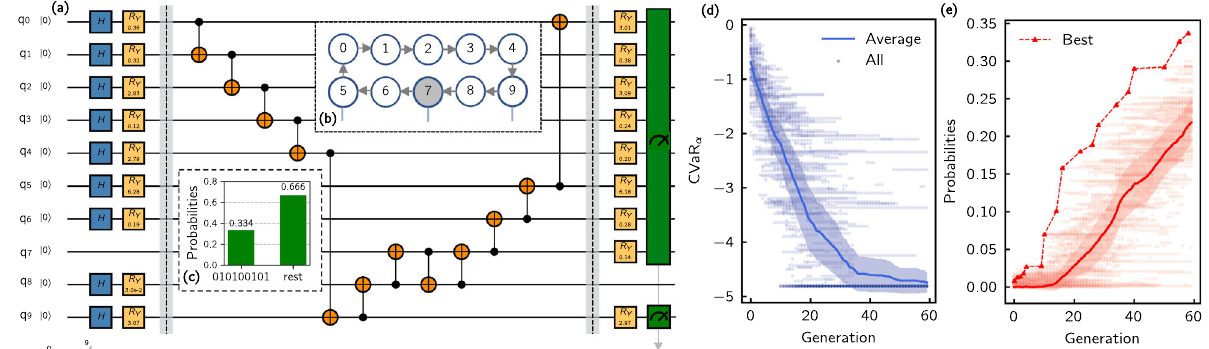
Fig. 3 Experiment results for the folding of the 7 amino acid neuropeptide. a Parametrized quantum circuit for the generation of the protein con fi gurations. The optimal set of qubit gate rotations is used to reconstruct the optimal fold. b Schematic representation of the ibmq_poughkeepsie 20-qubit backend used in this experiment. Qubit 7 is used to close the loop by swapping with qubit 8. c Converged maximal ground state probability for the ground state fold, max p P 0 ð p Þ . d Evolution of the ground state probability during the CVaR-VQE minimization (i.e., number of generations) with α parameter set to 5%. e Evolution of the mean probability (over the population ensemble, P h P 0 ð p Þi ) and of the best individual probability for the ground state fold, max 0 ð p Þ p